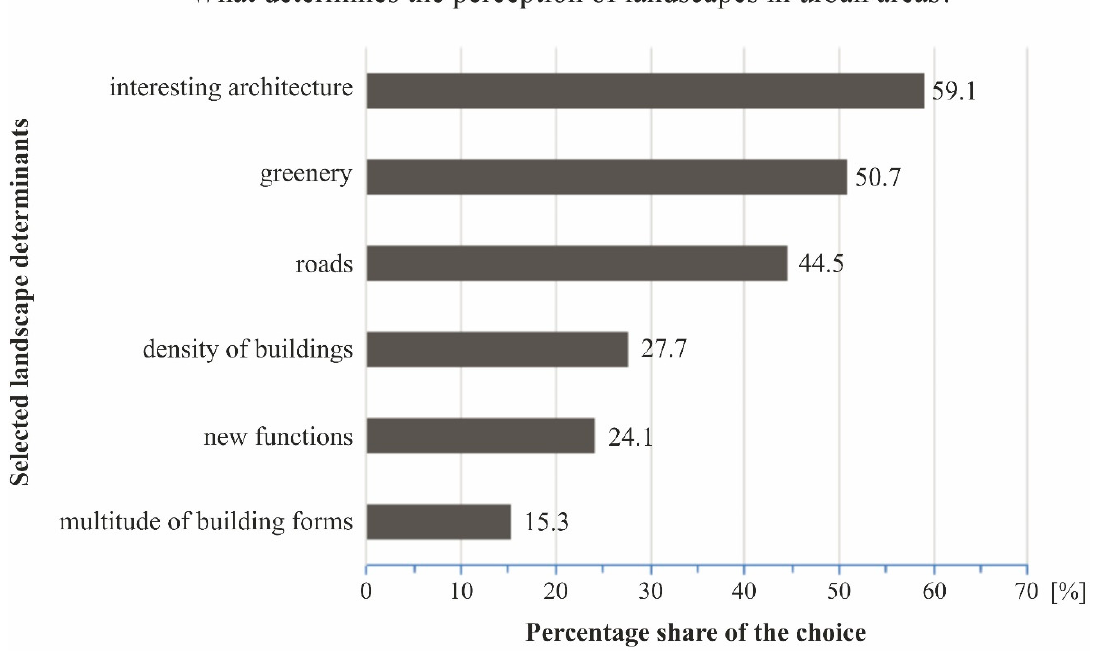
Figure 3. Characteristics determining the perception of the urban landscape (EnvEng and CivEng students combined, n = 244).